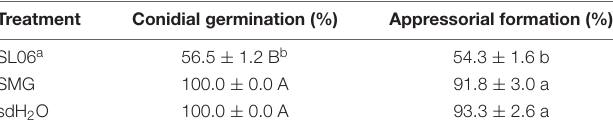
a SL06: Two hundred-fold diluted culture filtrate of S. griseorubiginosus LJS06; SMG, two hundred-fold diluted soybean meal broth; sdH 2 O: sterile distilled water. b Means (n = 4) ( ± standard error) in the same column followed by different letters are significantly different (p < 0.05) according to Fisher’s least significant difference